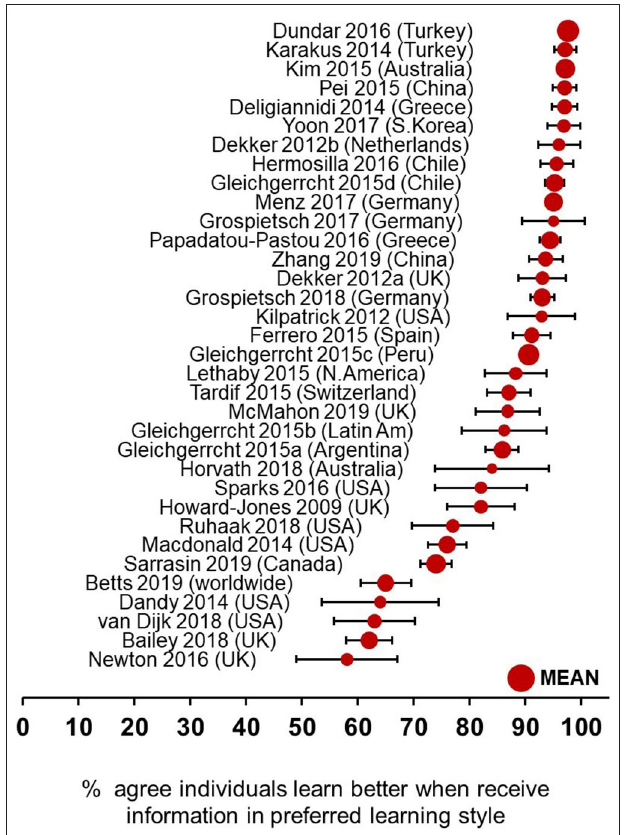
FIGURE 1 | The percentage of participants who stated agreement that individuals learn better when they receive information in their preferred Learning Style. Individual studies are shown with the name of the first author and the year the study was undertaken. Data are plotted as ± 95% CI. Bubble size is proportional to the Log10 of the sample size.